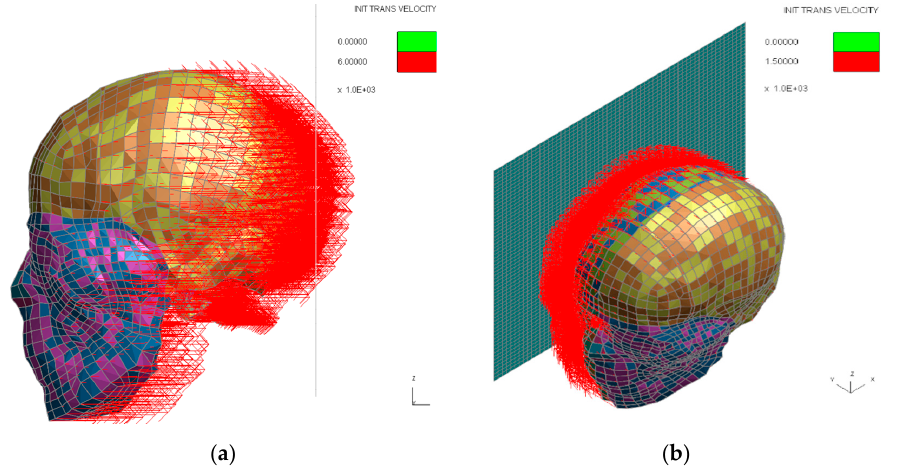
Figure 9. Setup of both load cases (occipital and parietal). ( a ) Occipital head impact velocity, ( b ) Parietal head impact velocity. head impact velocity.